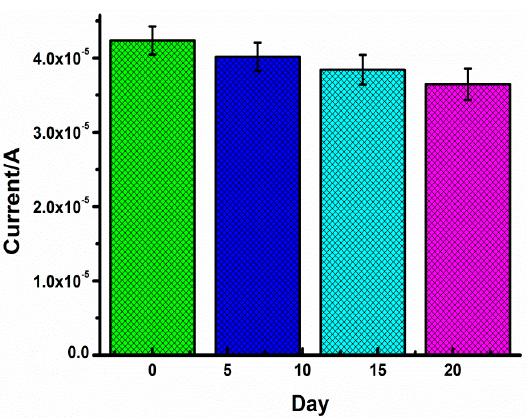
Figure 7. Aptamer-Au-TH–CG/GCE storage at 4 °C for 0, 7, 14, and 21 days with 10 pM tau381 (n > 3).